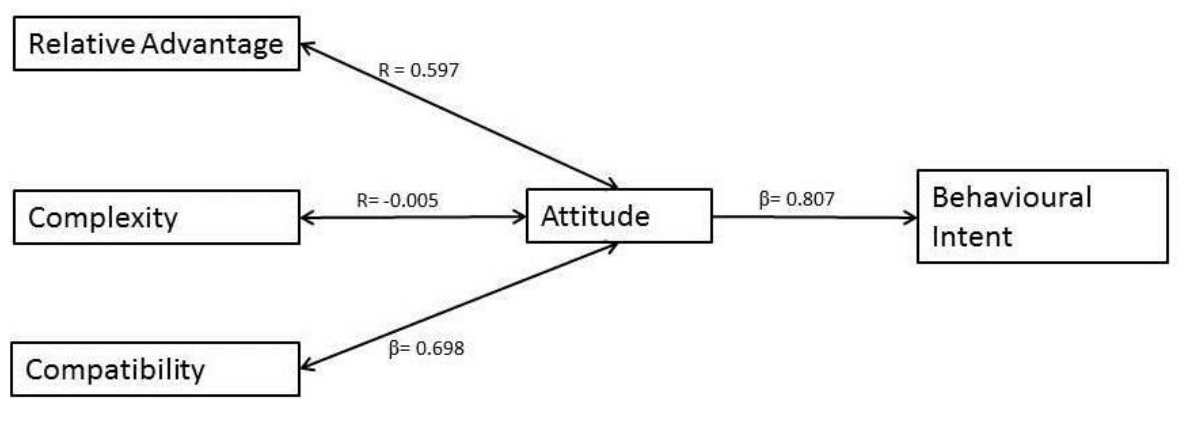
Figure 2. LMS usage model in an ODL